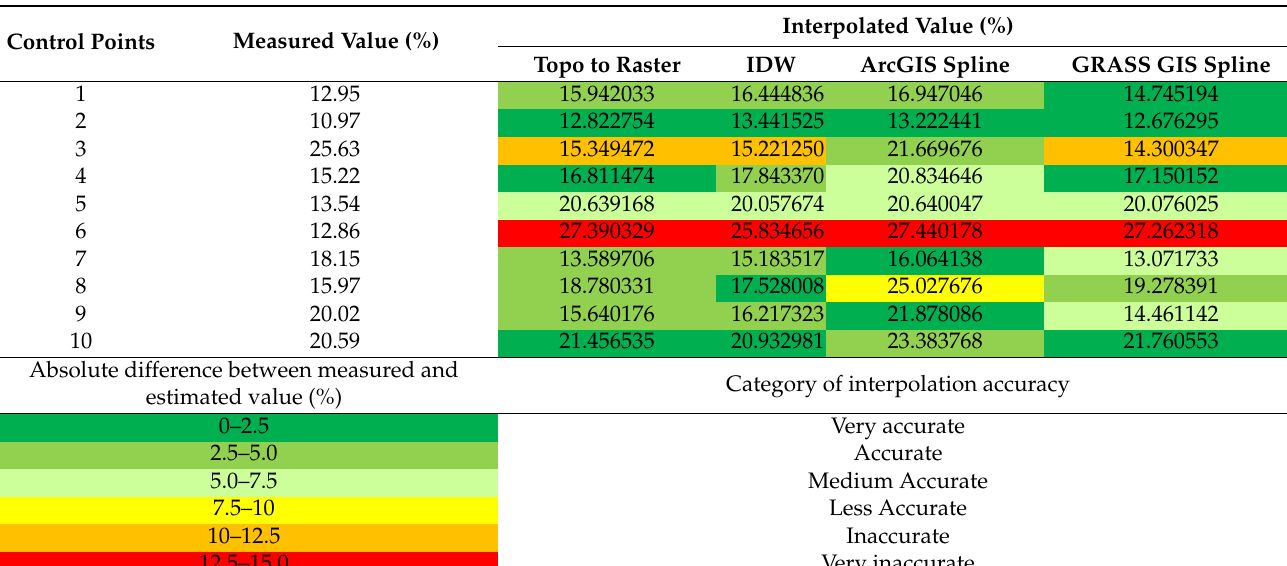
Table 4. Evaluation of the clay fraction content <0.001 mm